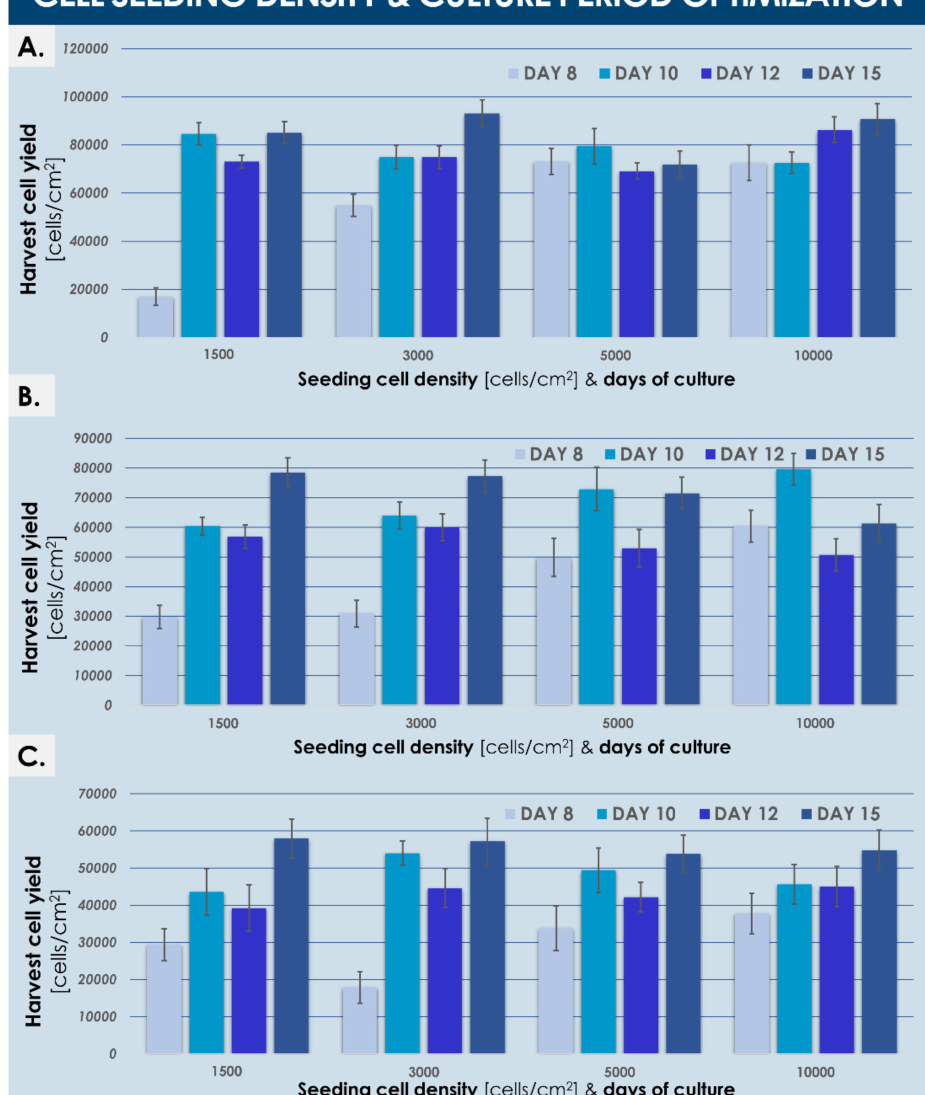
Figure 1. Results from the pilot GMP banking campaign for optimization of dermal FPC seeding density, culture vessel surface, and total culture period. Expansion of dermal FPCs at passage 6 took place in standard culture flasks of different surfaces (i.e., ( A–C ), T175, T225, and T500 flasks, respectively). Expansions were performed using a Sigma ® clinical-grade FBS lot and the relative volume of culture medium was of 0.2 mL/cm 2 . Culture medium was exchanged twice per week. The total number of days in culture was calculated from the time of vessel seeding to the time of confluent (i.e., 100% confluency) cell monolayer harvest. Standard deviations are presented as error bars. Overall optimized conditions (i.e., a compromise between sparing use of resources and consistent quality of manufactured cells) were established with the use of T225 flasks, a cell seeding density of 1.5 × 10 3 ± 200 cells/cm 2 , and harvest of confluent cells after 15 days of culture maintenance. FBS, fetal bovine serum; FPC, fibroblast progenitor cells; GMP, good manufacturing